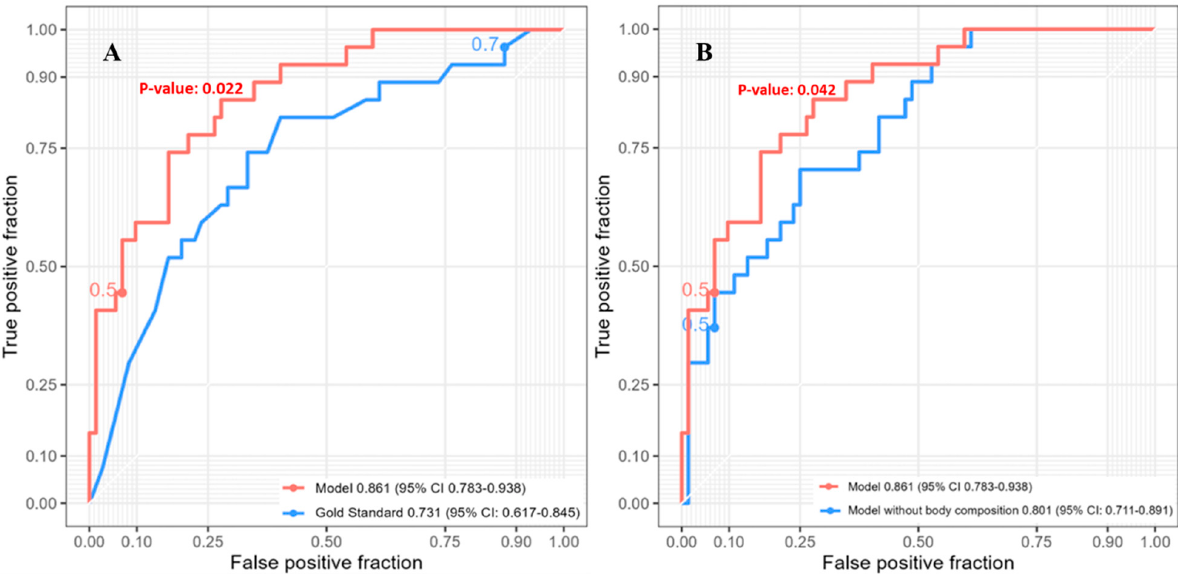
Figure 3. ROC curves of SVM models predicting five-year post-esophagectomy survival (n = 99). ( A ) Full SVM model and reference model. ( B ) Full SVM model and SVM model without body composition variables. SVM = support vector machine. ROC = receiver operating